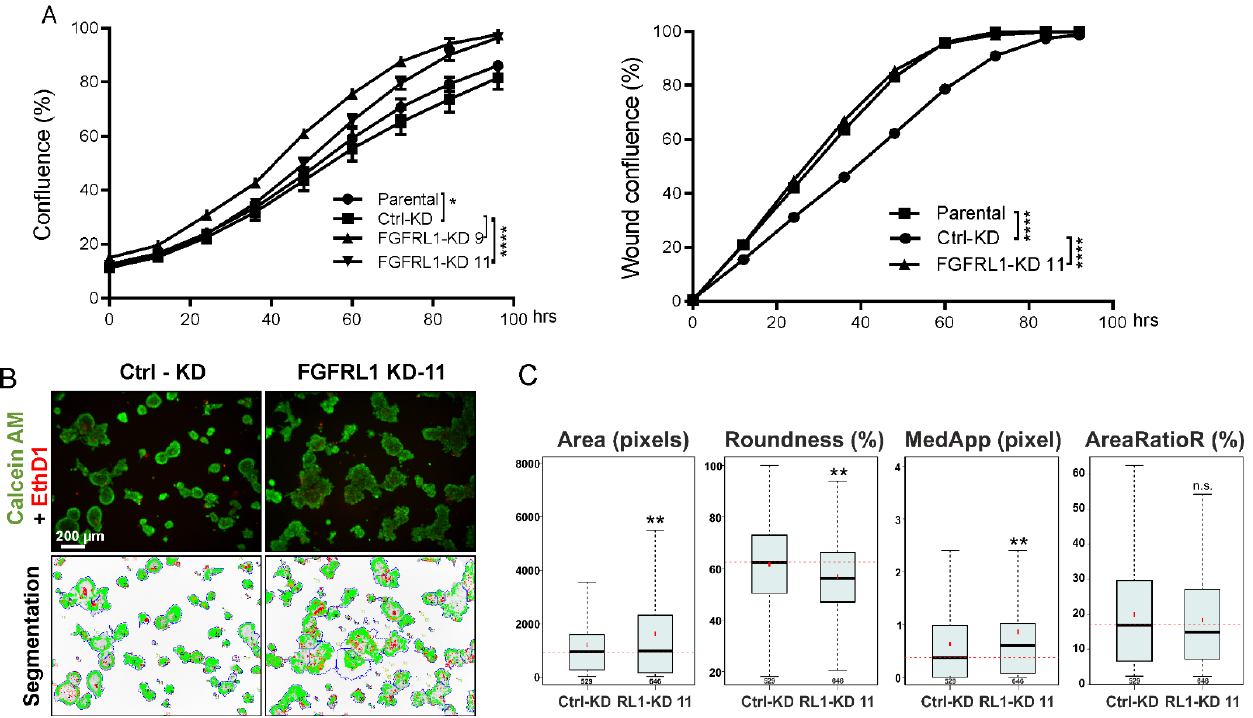
Figure 4. Functional analysis of PC3M cells with stable knockdown of FGFRL1 in vitro. ( A ) Cell proliferation (left) and migration (right) of control (ctrl-KD) and FGFRL1 knockdown (FGFRL1-KD) PC3M cells in 2D cultures were examined using IncuCyte imaging device in real time (two-way ANOVA, * p < 0.05, **** p < 0.001). ( B ) Cells were cultured in organotypic 3D culture system in Matrigel for 12 days. At the end point, the cells were stained with Calcein AM and Ethidium homodimer (EthD-1) and imaged with confocal microscope (upper panel). Phenotypic analysis was performed with AMIDA software (lower panel, image segmentation). ( C ) Quantitation of object size ( Area ), the shape of objects ( Roundness and MedApp ), and the relative amount of red fluorescence in an object ( AreaRatioR ), indicating cell death, are presented as box-and-whisker plots (Bonferroni-corrected t -test, ** p < 0.001; n.s., not significant). The total number of analyzed objects (in 6 replicate wells) is indicated under the whisker of the box-and-whisker plots.